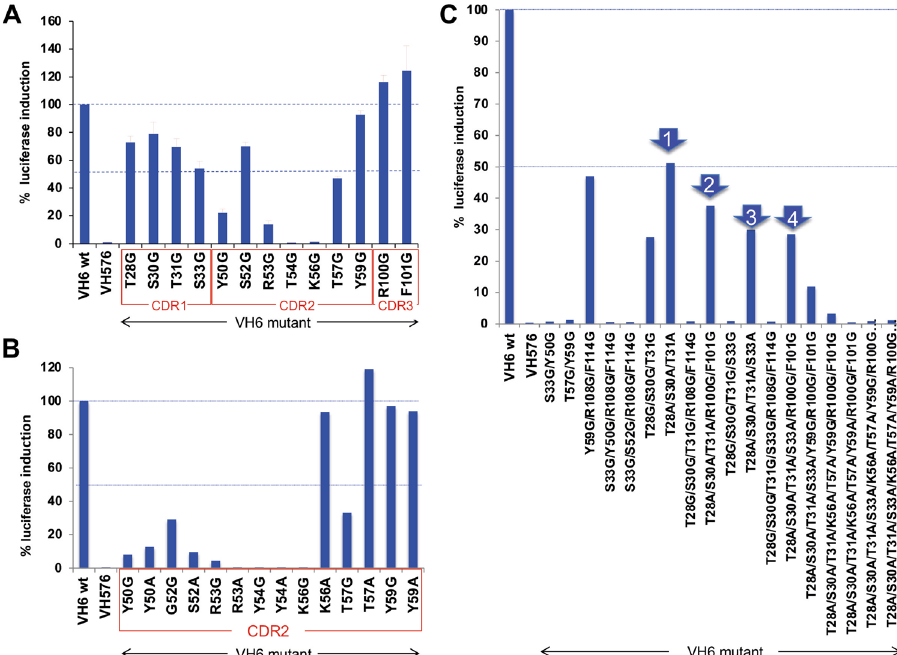
Figure 1. Mutagenesis of anti-RAS iDAb by glycine-alanine scanning of VH CDRs analysed with mammalian two hybrid assays. Mammalian two hybrid assays were carried out to delineate key residues for interaction between RAS and anti-RAS VH6 iDAb. The triplex plasmids 2 with HRAS G12V baits (Gal4 DBD fusion) and various anti-RAS VH6 mutant preys (VP16 fusions) were transfected into a CHO line with stable integration of the firefly luciferase reporter gene (CHO-luc15). Interaction signals measured by firefly luciferase gene activation are normalized to Renilla luciferase activity (assessed as percentage of luciferase activity compared to positive control using wild type unmutated anti-RAS VH6 (VH6 wt)). An anti-LMO2 VH576 iDAb was used as negative control. Panel ( A ): VH6 mutants with glycine substitution on CDR1, 2 and 3. The residue number of mutant on x-axis indicate according to IMGT numbering system (see also Supplementary Fig. 2 showing the sequence of the iDAb VH6). All the chosen mutated residues shown are known to be direct contacts to RAS proteins 3 . Panel ( B ): Glycine or alanine mutations of VH6 residues on CDR2. Panel ( C ): Effects of combining glycine and/ or alanine mutations in combination from CDRs 1, 2 and 3 of iDAb RAS. The four combinations (arrowed 1–4) were used to inform the decision on the final set of mutations in the dematured iDAb